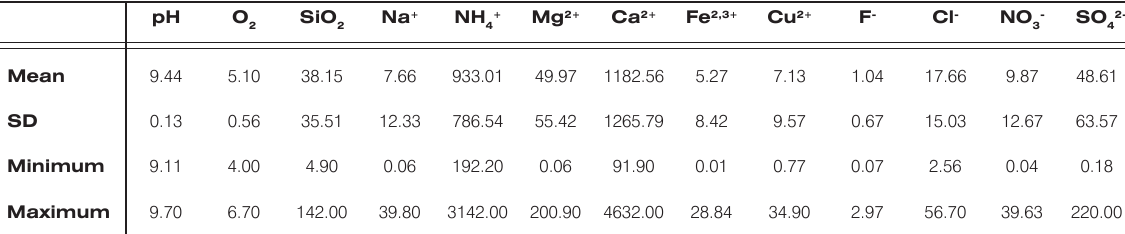
Table 5. Descriptive statistics of the elemental concentrations (µg L -1 ) in 33 water–steam